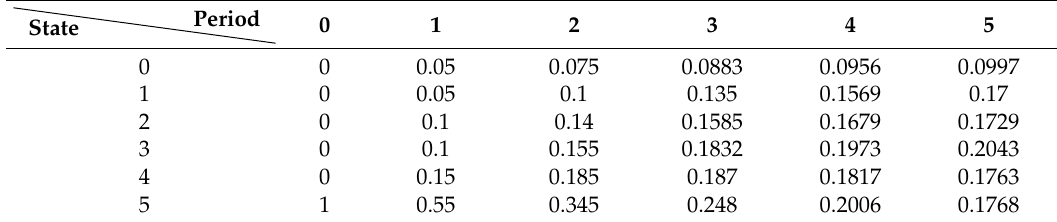
Table A3. Probability distribution of component 3 using the SMV approach.